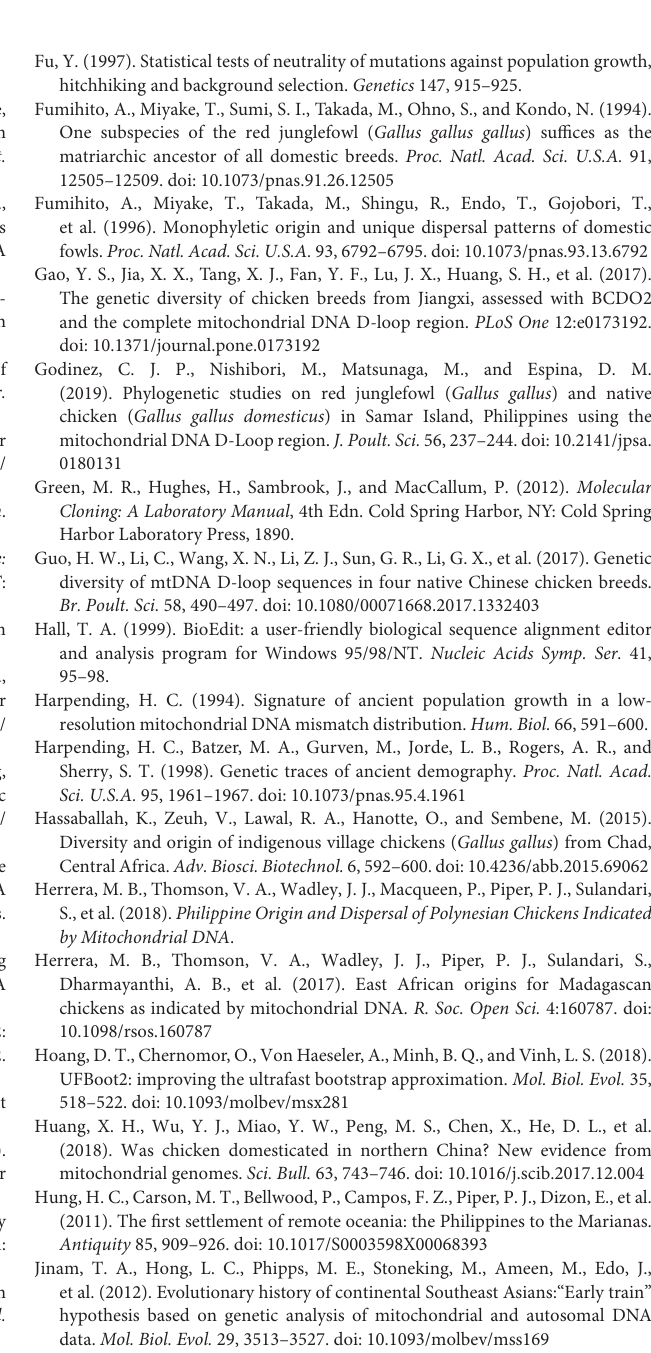
Supplementary Figure 1 | Maximum likelihood (ML) phylogenetic tree showing four haplogroup classifications (predominant haplogroup D) of Philippine chickens and different classifications from other neighboring countries. Node labels correspond to bootstrap support values evaluated with 1,000 ultrafast bootstrap replicates in IQ-TREE. The scale bar (0.007) indicates the genetic distance (substitution per site). Supplementary Figure 2 | Median-joining (MJ) network of mitochondrial DNA (mtDNA) D-loop Hypervariable region (HVR) illustrating the genealogical relationships of chickens from Philippines (green), Indonesia (red), and Pacific (yellow) using all observed haplogroup D haplotypes ( Supplementary Table 3 ).